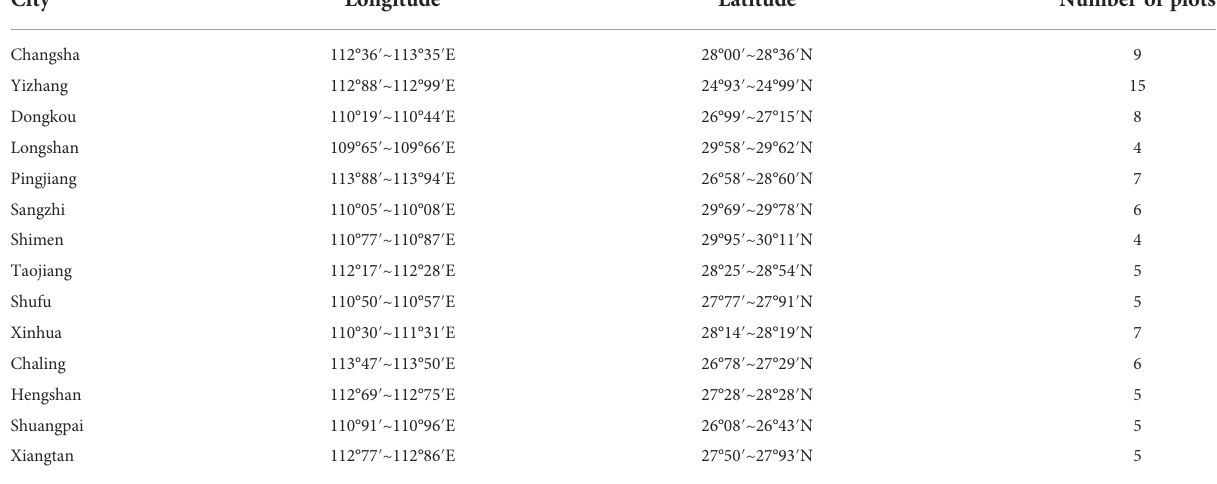
TABLE 1 Site selection and quantity of plots in Hunan Province, China.